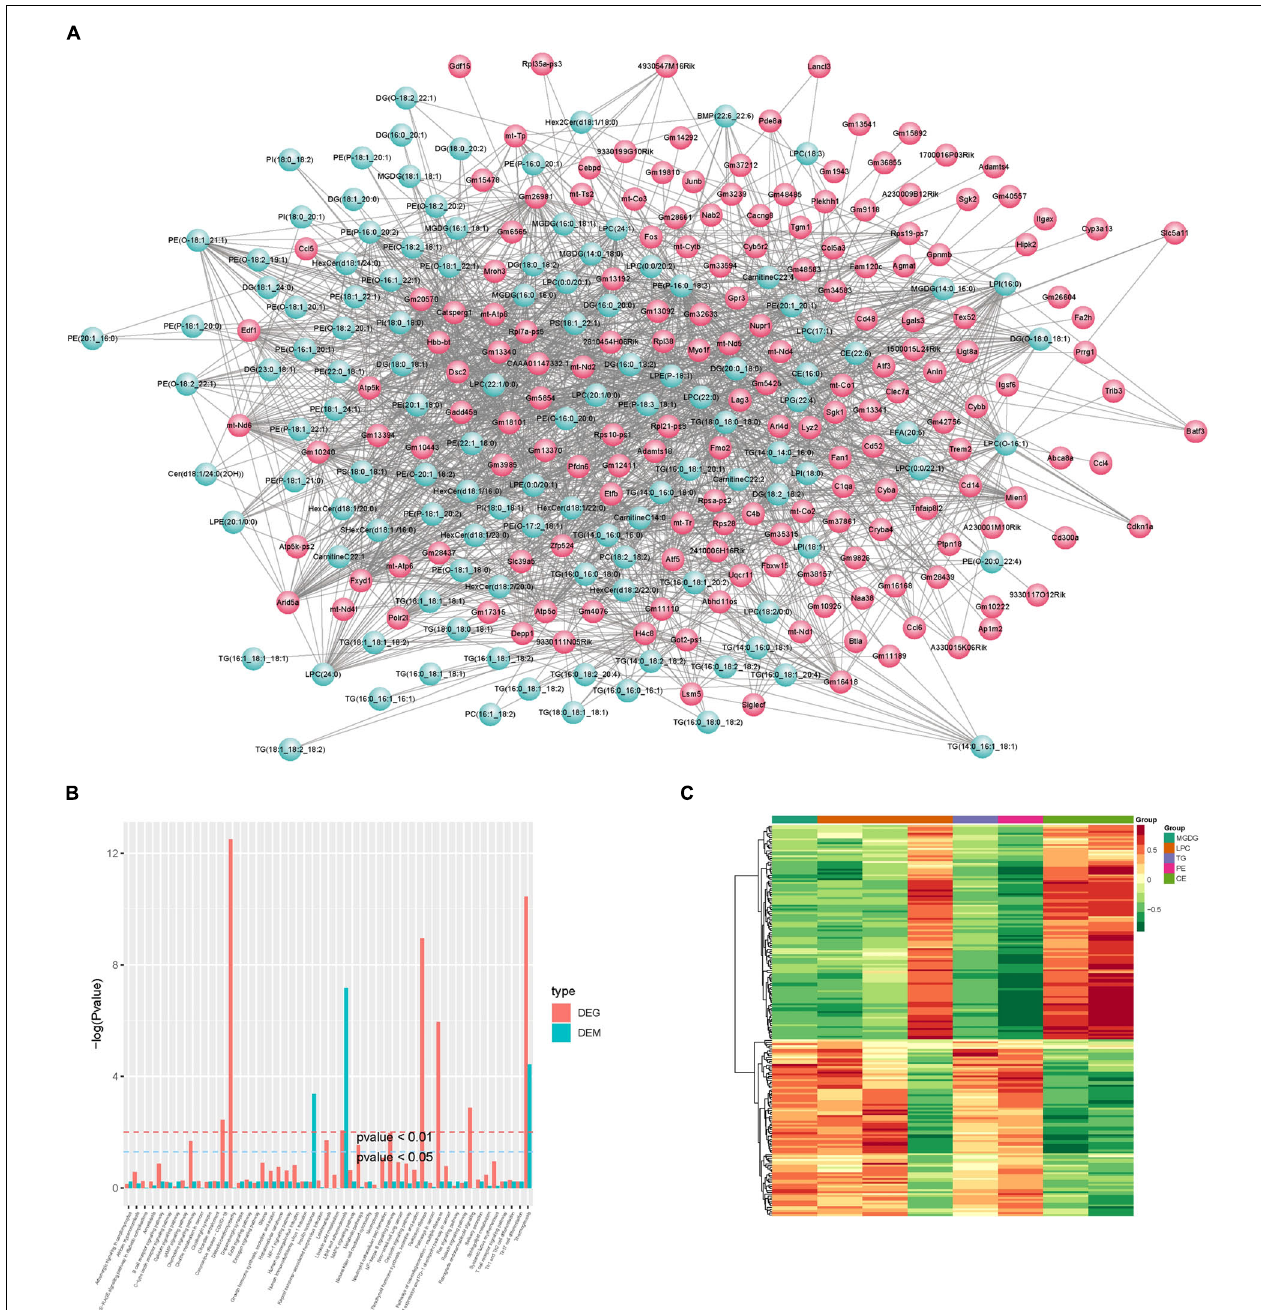
FIGURE 10 | (A) Plot of total correlation network between differential metabolites and genes. (B) Histogram of pathways. (C) Heatmap of correlation coefficient